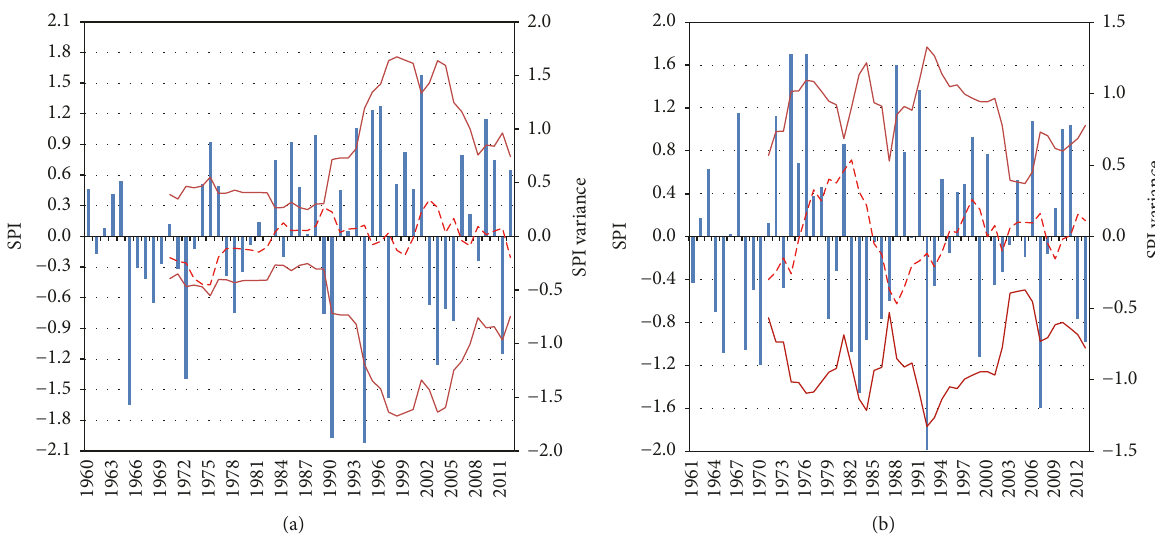
Figure 3: Temporal manifestation of the SPI (bars) for (a) OND and (b) JFM at provincial level. In the insert are the 10-year running variance envelope (solid lines) and mean (dashed line). The SPI is from 1960 to